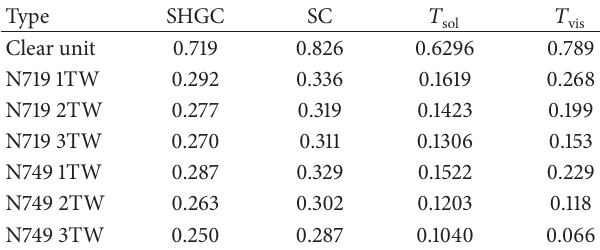
Figure 7: Composition of DSC glazing. Table 4: Thermal performance and optical performance of the win- dow